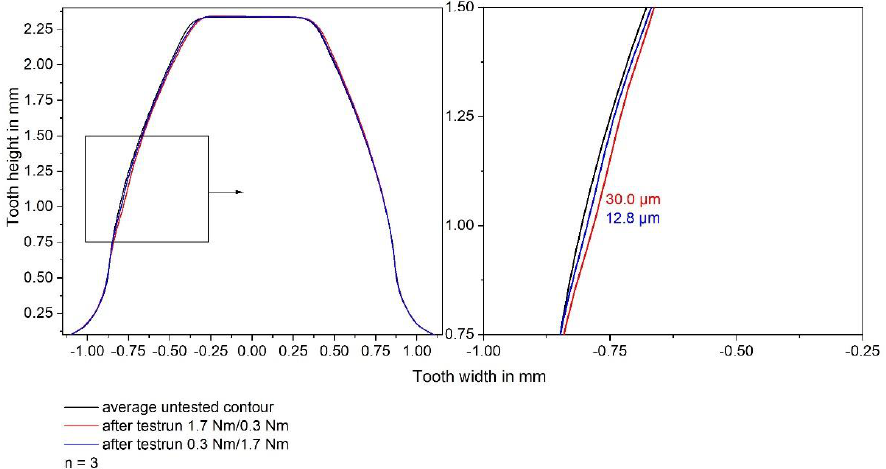
Figure 9. Coordinate measurements of gears tested with one load change in different sequence. The coordinate measurements show almost exclusively tooth flank wear. At the tooth tip of the side not in contact with the pinion minor plastic deformation can be seen. The tooth flank wear of the side in contact is not distributed uniformly. Wear mainly occurs in the tip area and below the pitch point with the greatest amount of wear being observed below the pitch point. The average contour of the gears tested with the low torque at the start of the test run shows much less wear, which supports the hypothesis mentioned above. However, the wear measured via the coordinate measurement machine is 12.8 µm for the test runs, with the low torque at the start, and 30.0 µm for the test runs with the high torque at the start. These values are much lower than the in situ measured tooth flank wears of 45.4 ± 3.5 µm (0.3 Nm/1.7 Nm loading torque) and 77.1 ± 6.5 µm (1.7 Nm/0.3 Nm loading torque). The deviation between in situ and ex situ measurements has already been analysed in a previous article by Herzog et al. [35]. The results show good correlation of in situ and ex situ measurements. However, the measured values are not the same since the in situ test rig measures timing differences during operation, and the coordinate meas- urement compares contours locally. Nevertheless, the Pearson correlation coefficient of 0.9818 indicates that the in situ gear test rig is qualified for measuring the gear wear and plastic deformation continuously. The measured temperature of the gears tested with one load change in different se- quence is shown in Figure 10. The maximum tooth root temperature of the gears loaded with 0.3 Nm first is about 47 °C ± 1 °C, whereas the maximum temperature of the gears loaded with 1.7 Nm first is about 43 °C ± 2 °C.